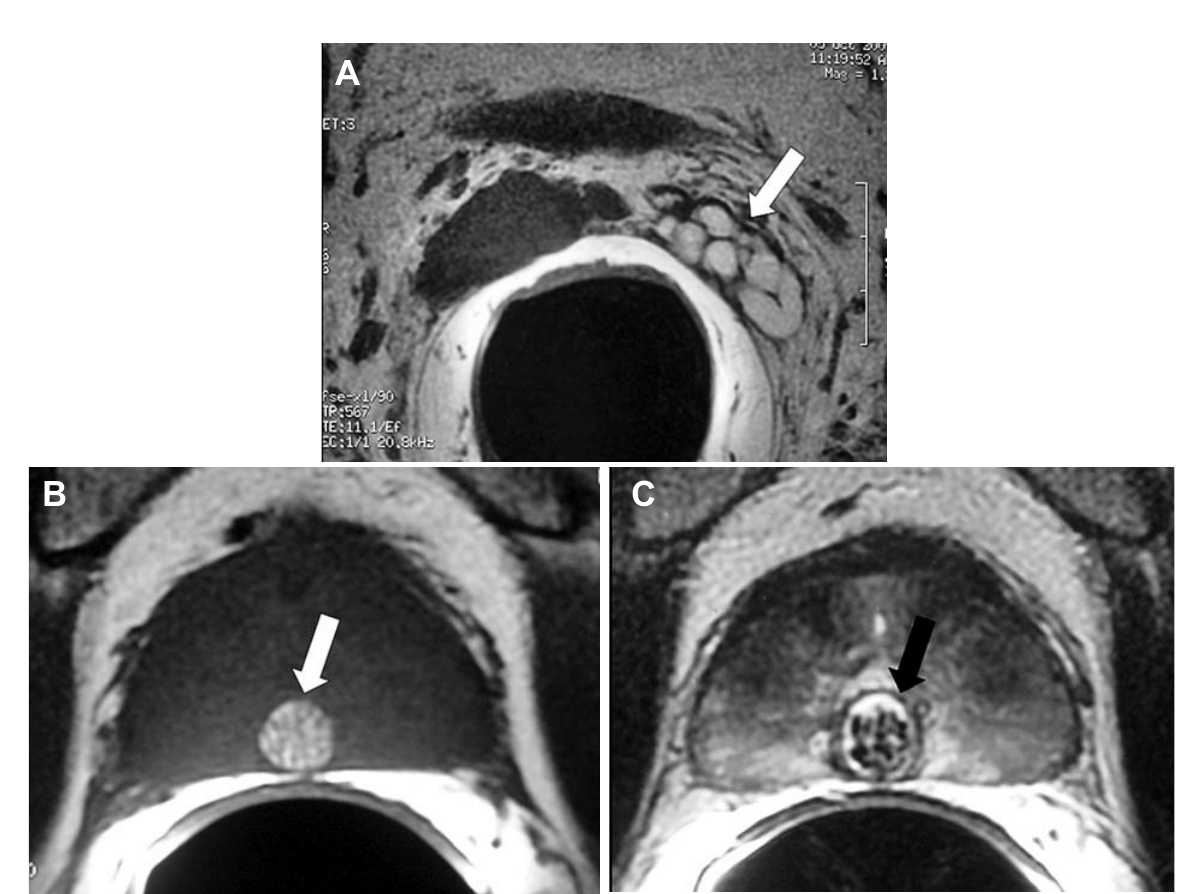
Figure 1 – Hemorrhagic seminal vesicle associated with a complicated midline prostatic cyst (utricular cyst). A 54-year-old man, with history of persistent hemospermia. A) E-MRI, axial plane, T1-weighted image, showing a hemorrhagic normal-walled left seminal vesicle (arrow). Hemorrhage is recognized due the presence of high signal intensity on T1-weighted images. B) and C) E-MRI, axial T1 and T2-weighted images respectively, showing a complicated midline prostatic cyst (arrow) containing blood and several small